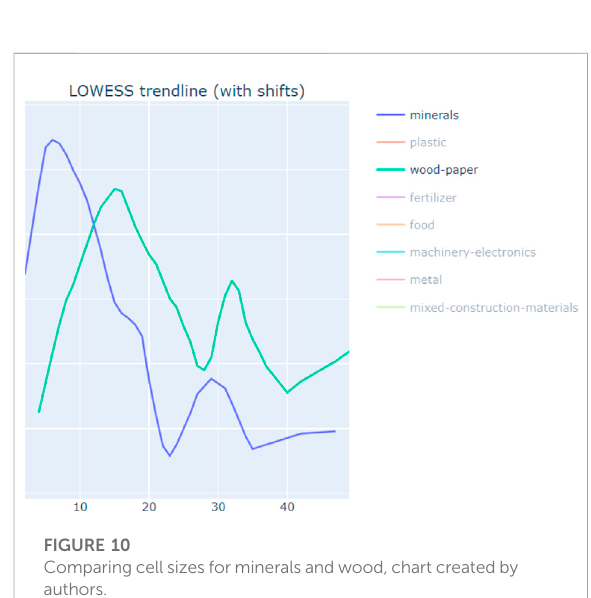
FIGURE 10 Comparing cell sizes for minerals and wood,chart created by